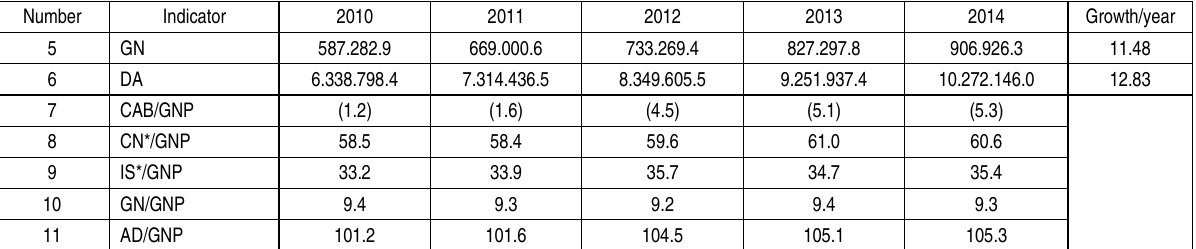
Table 1 (cont.). National income, domestic absorption, and Indonesian current account balance, 2010-2014 (billion rupiah)